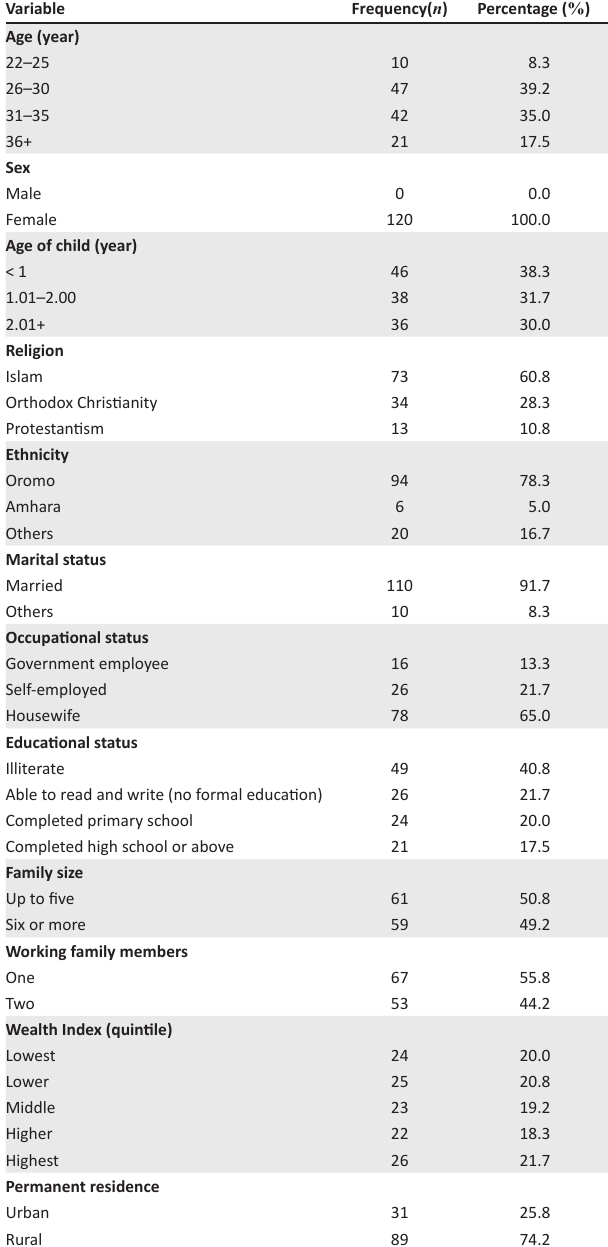
TABLE 1: Sociodemographic profile of respondents and family, Jimma,